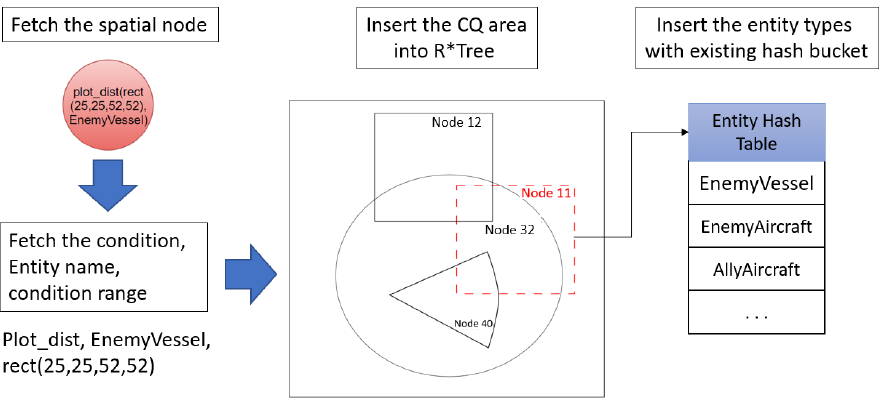
Figure 6. Inserting a spatial node into an